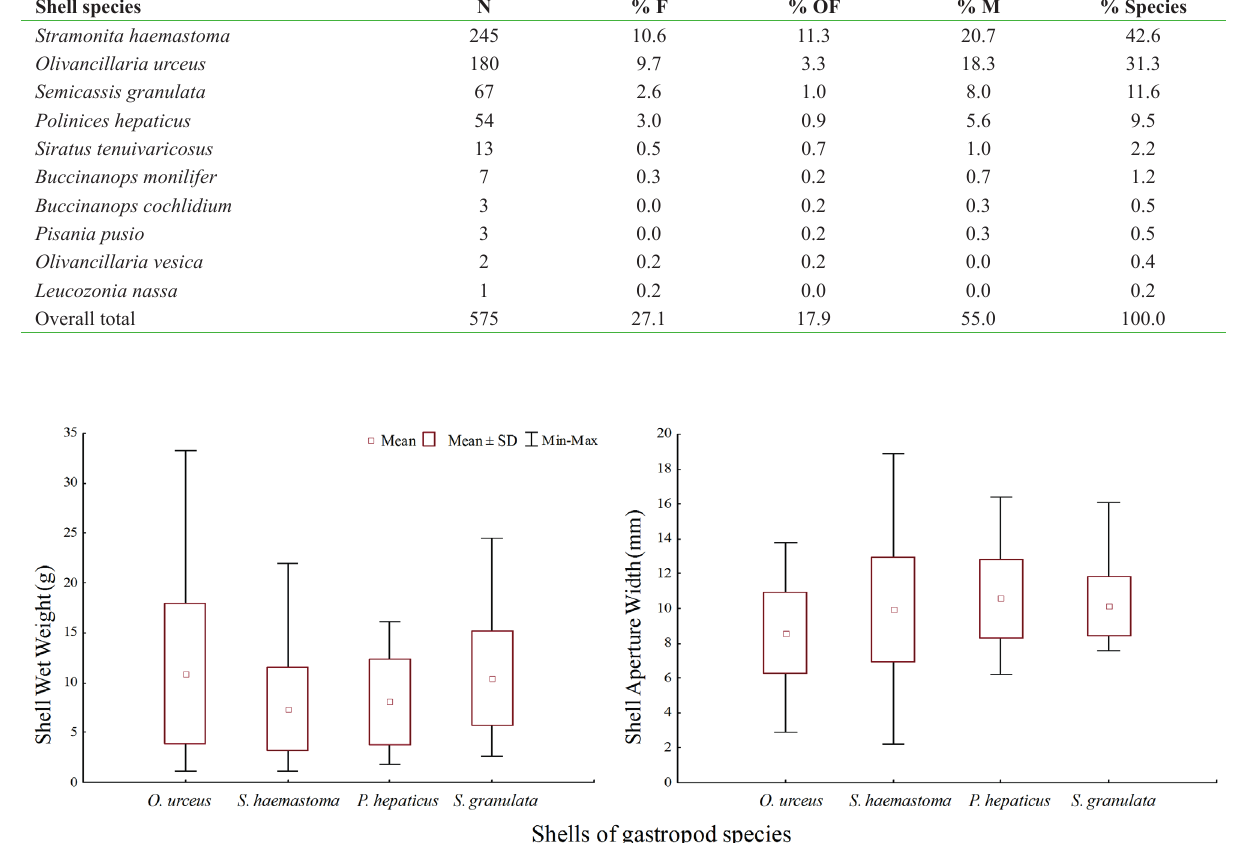
Table 1. Overview in the shell occupation by interest group: females (F), ovigerous females (OF) and males (M) of the hermit crab Isocheles sawayai in an area adjacent to Babitonga Bay, Santa Catarina, Brazil. Shell